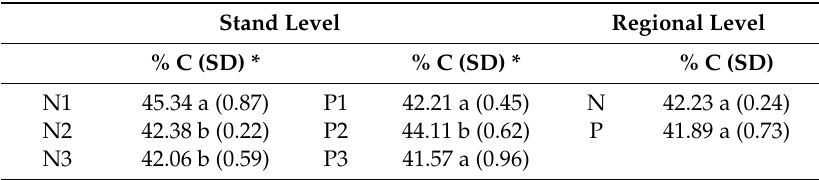
Table 2. ANOVA and t -test results (mean (standard deviation)) between the percent carbon (% C) of natural (N1, N2, N3) and planted (P1, P2, P3) stands and the regionally averaged natural (N) and planted (P) % C from stands in the John Prince Research Forest with Bonferroni (*) post hoc. Di ff erent letters indicate significant di ff erences among the groups ( p < 0.05). Stand